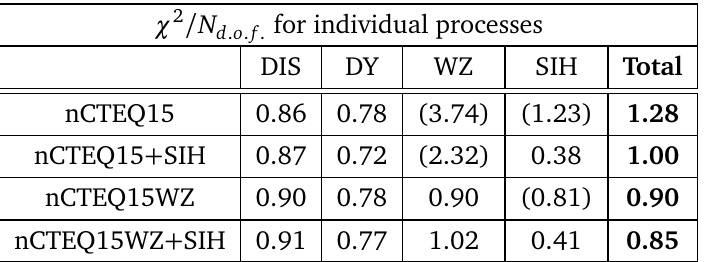
Table 2: χ 2 / N for the individual processes DIS, DY, WZ, SIH, and the total. dof Excluded processes are shown in parentheses. (Note that nCTEQ15 and nCTEQ15WZ include the neutral pion data from